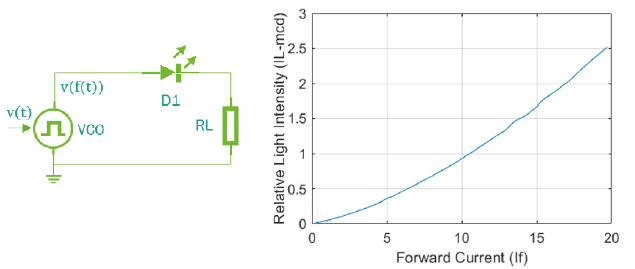
Figure 10. Base circuit to estimate brightness control and brightness intensity versus forward current